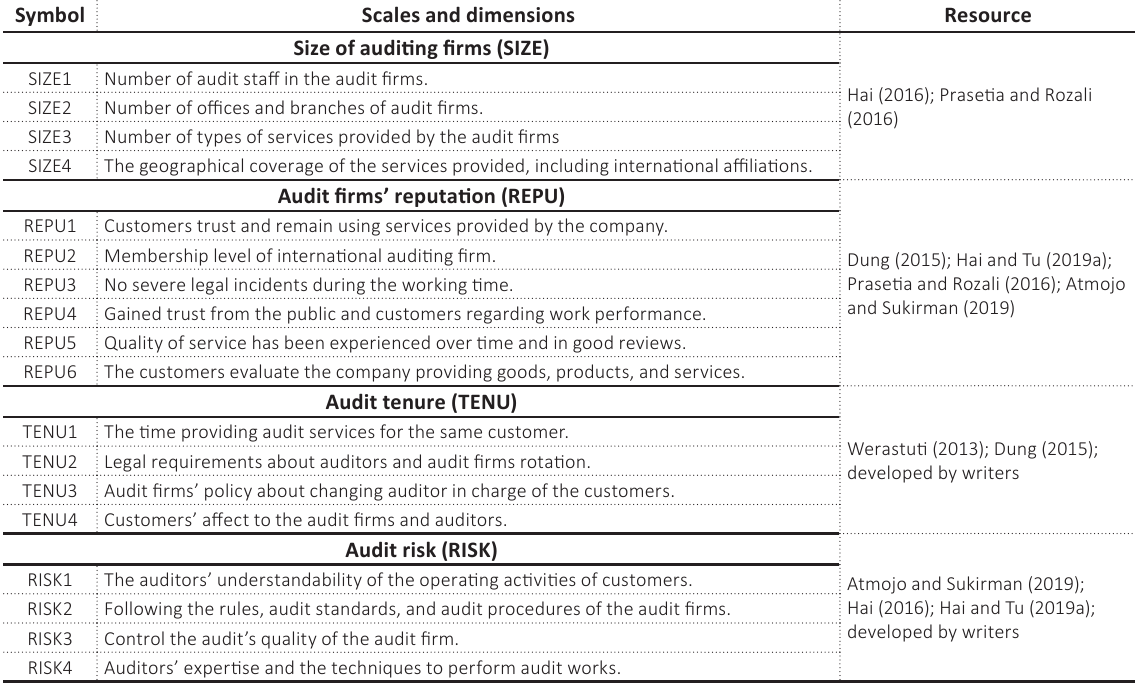
Table 2. Dimensions and scales Symbol Scales and dimensions